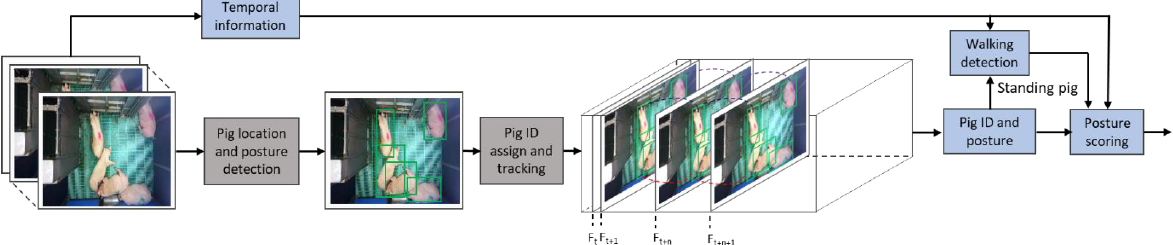
Figure 2. Complete steps of proposed methodology. The pig postures are identified and localized by using a deep-learning object detection model, then the simple online real-time tracking with deep association (Deep-SORT) algorithm tracks each pig by associating the corresponding detected posture, and, finally, the detected pigs’ postures with time information are analyzed to score the posture activity occurring in an hour. All the modules are integrated to provide an end-to-end posture scoring.